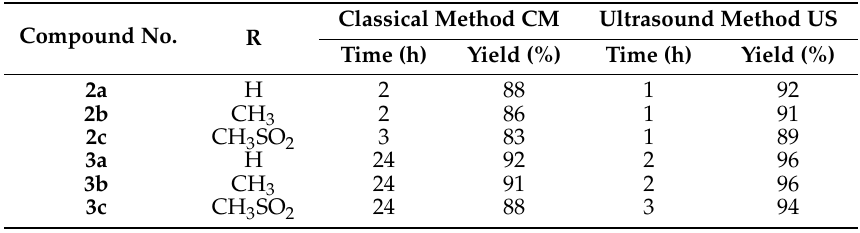
Table 1. Conventional versus ultrasound synthesis of compounds 2a – c and 3a – c . Classical Method CM Ultrasound Method US Compound No. R Time (h) Yield (%) Time (h) Yield